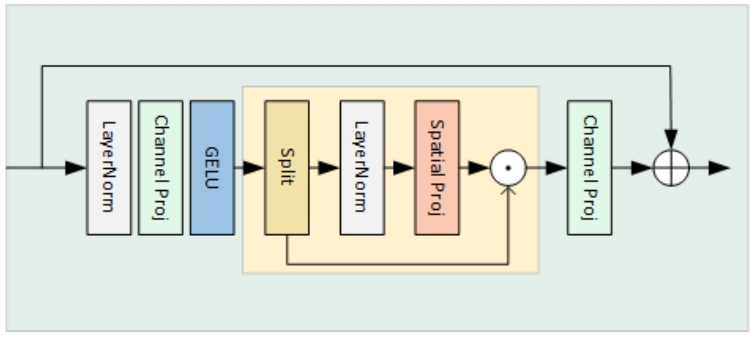
Figure 7. The gMLP Block.